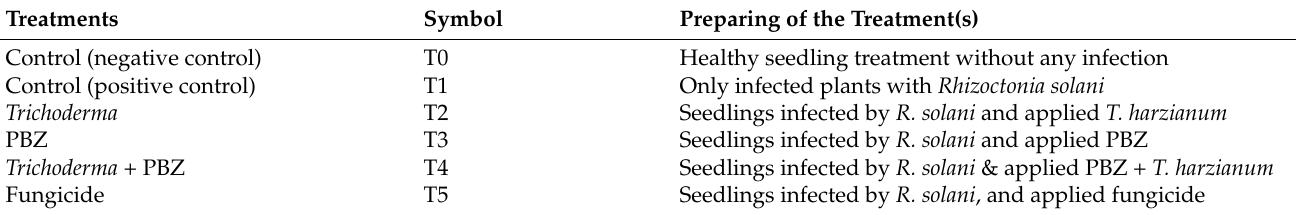
Table 1. List of treatments for infected plants with Rhizoctonia solani , symbols, and more details. Treatments